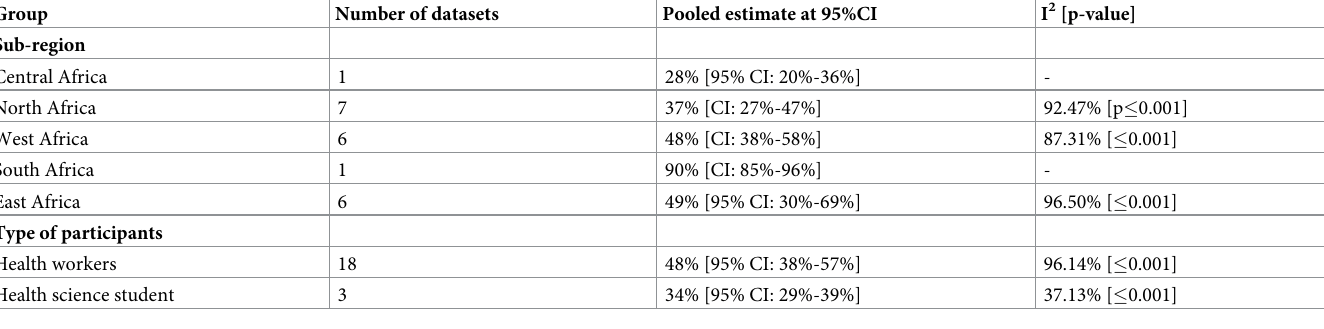
Table 2. Pooled COVID-19 vaccine acceptance rate stratified by sub-region and type of participants.